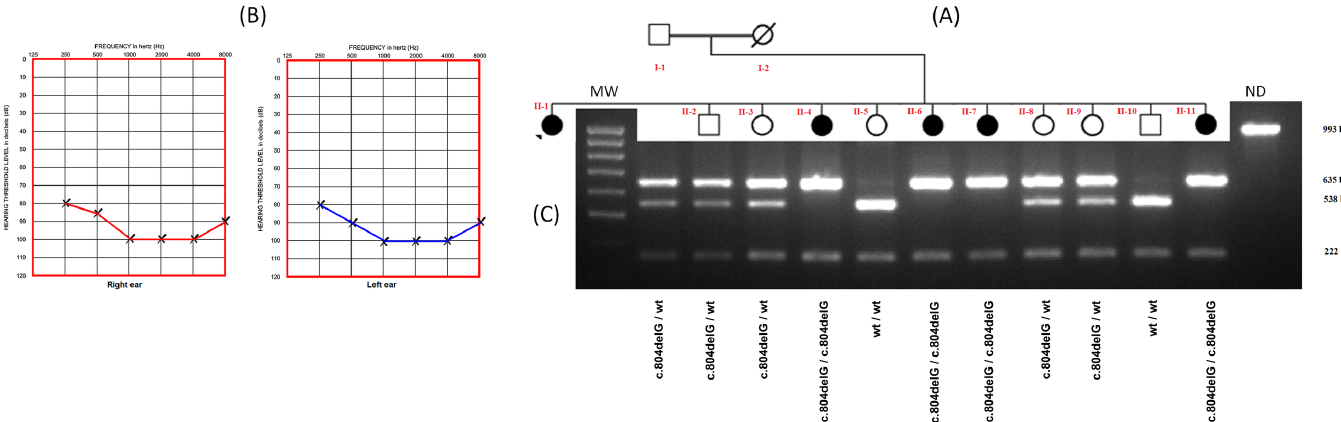
Fig 1. Pedigree of the affected family, Audiogram and PCR-RFLP analysis. (A) Pedigreeof the affected family with nonsyndromic hearingloss. Arrow denotesthe proband.(B) Audiogramof the probandindividual II-1 exhibitingbilateral,severe to profoundsensorineural hearingloss. (C) Results of PCR-RFLP analysisof DNA of the affected family with nonsyndromic hearingloss. A 993 bp PCR fragment is digestedwith FauI restriction enzyme. The wildtypeDNA is cleavedinto four fragments 538, 222, 136 and 97 bp, whereasthe c.804delGmutant alleleis cleavedinto three fragments 635, 222 and 136 bp in length. MW: DNA Ladder(100bpDNA Ladder, REF G2101) (Promega, USA); ND: undigested PCR product.